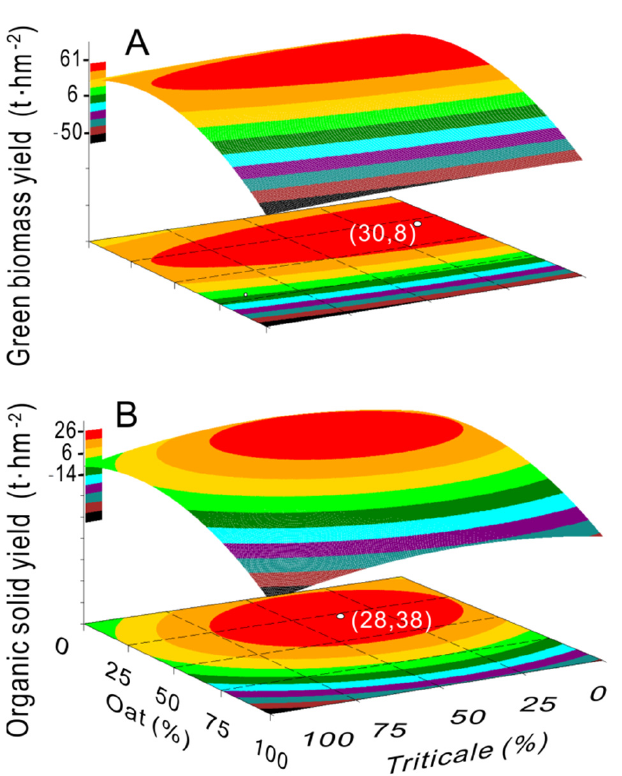
Figure 4. Response surface plots showing the interactions between oat and triticale on the green biomass yield ( A ) and organic solid yield ( B ).